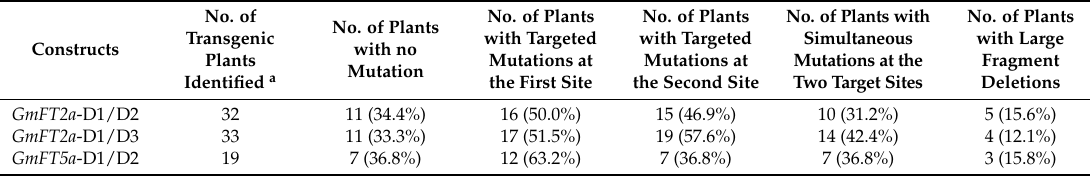
Table 2. Frequencies of the site-specific mutations at each target site and large fragment deletions